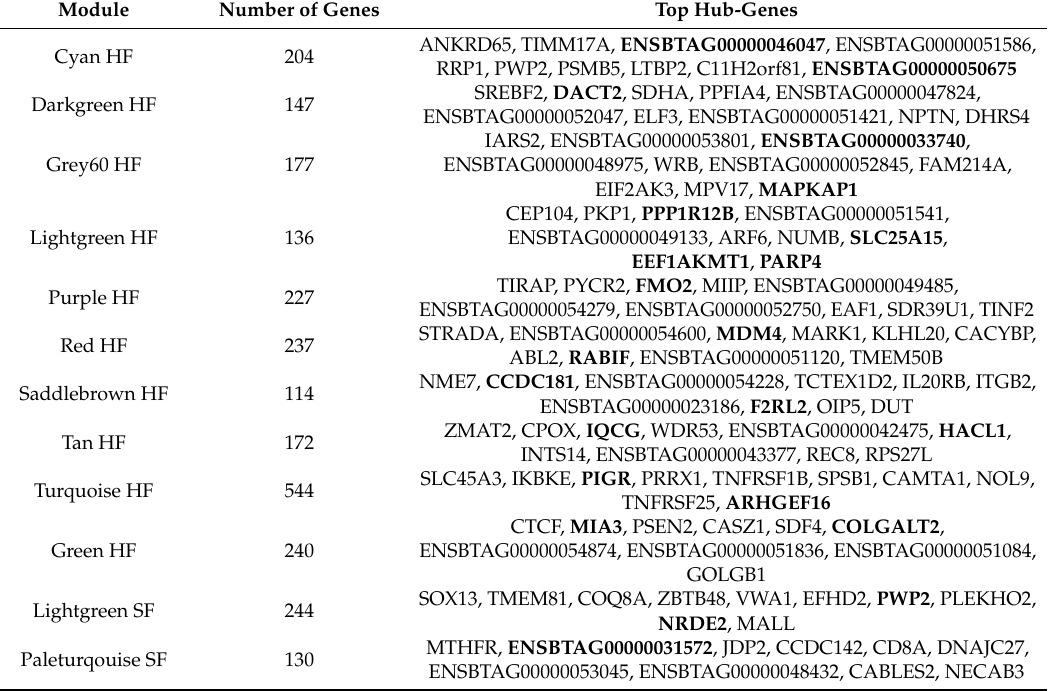
Table 1. Di ff erentially co-expressed gene modules (DcoExp), and their respective top 10 hub-genes between high-fertile (HF) and sub-fertile (SF)